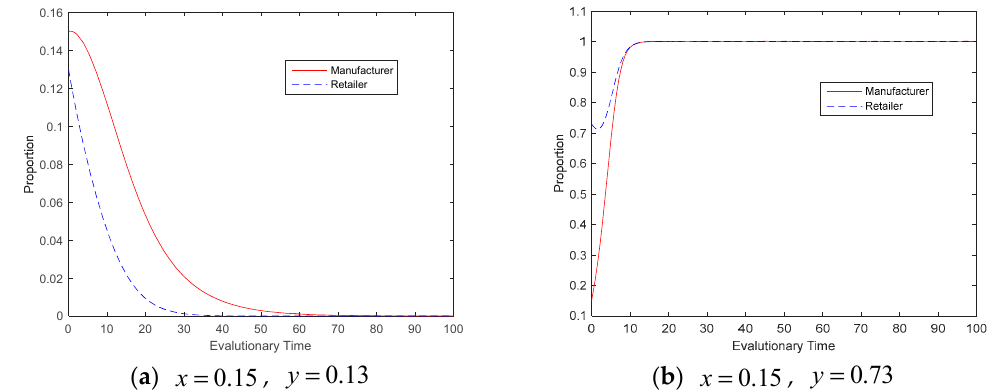
Figure 6. The Evolution Process of Evolutionary Stable Strategy of E 1 ( 0,0 ) or E 4 ( 1,1 ) .